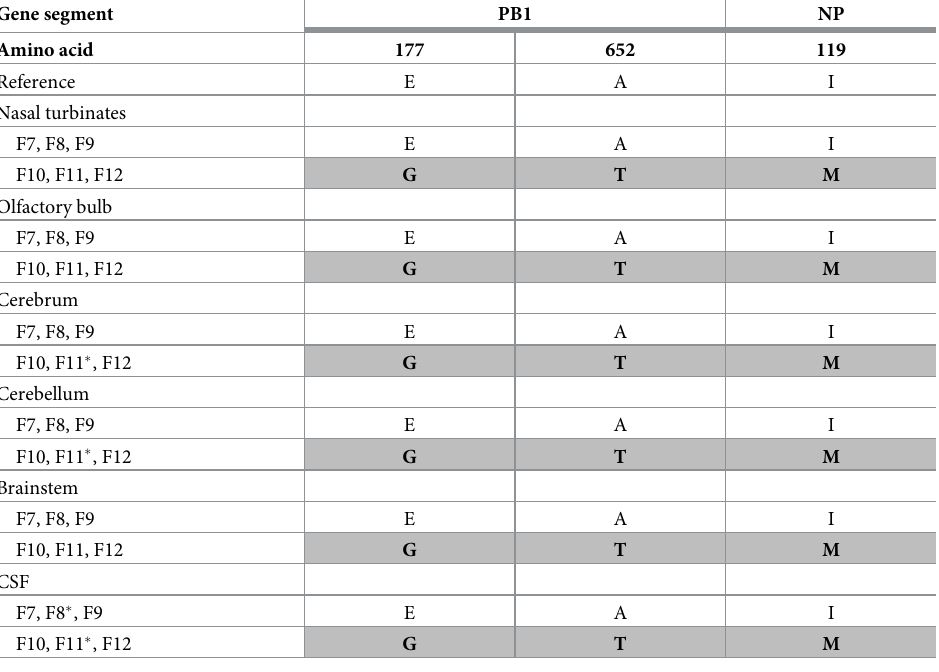
Table 5. In vivo stability of molecular signatures for CNS-mutations’ sites at 6 dpi.